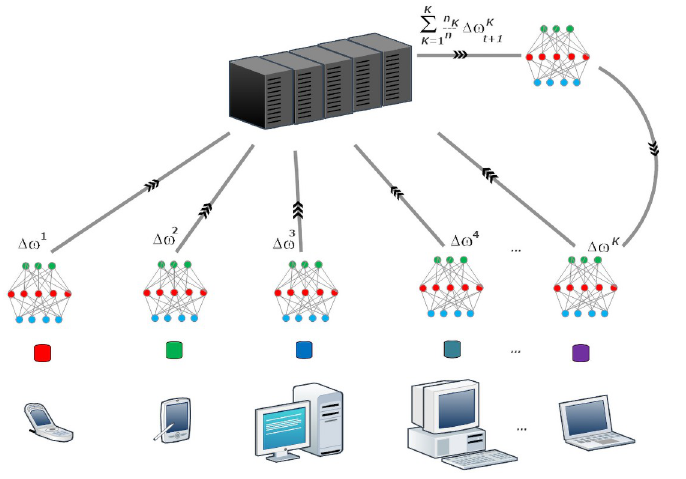
Fig 1. The global model collects local models